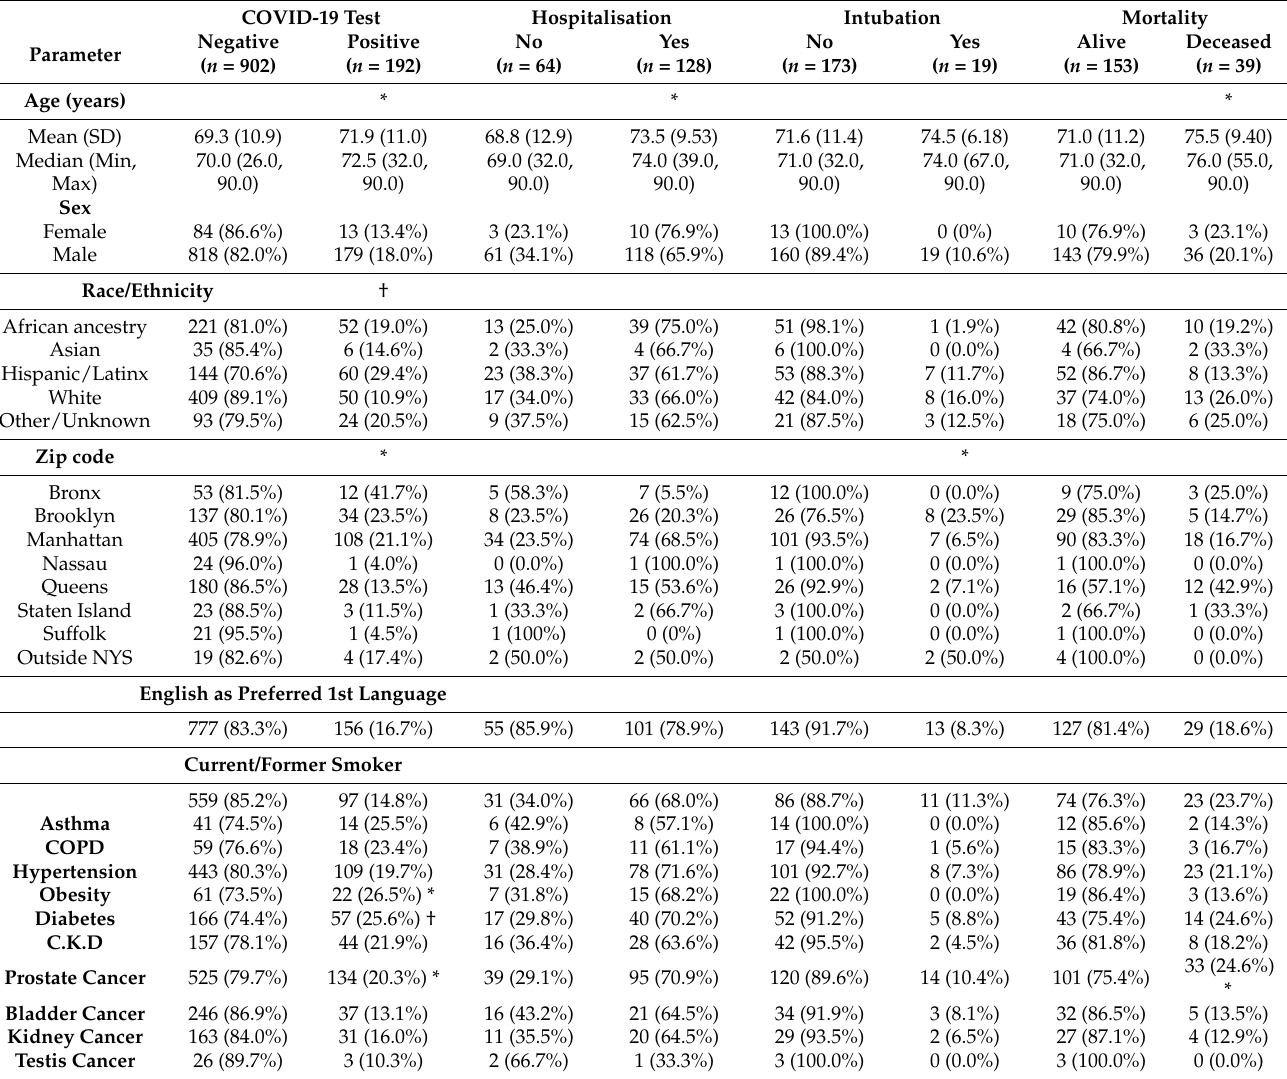
Table 1. Urologic cancer patient social and clinical demographics. * indicates p < 0.05; † indicates p < 0.001. Total percentages for prostate, bladder, kidney and testis cancer do not sum to 100% as patients may have had a diagnosis of more than one